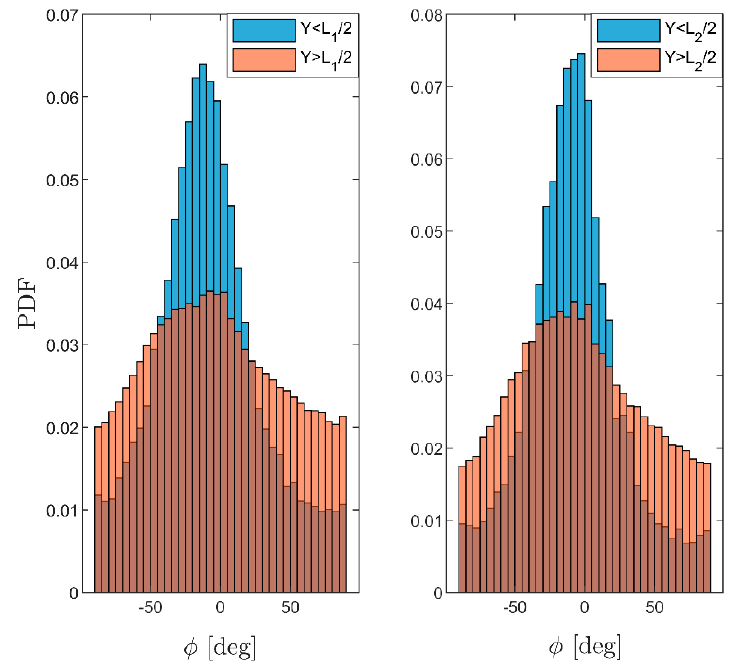
Figure 13. Estimate of probability density function of fiber orientation angle φ conditioned to fiber distance from the wall. Low aspect ratio k 1 fibers ( left ), high aspect ratio k 2 fibers ( right ).